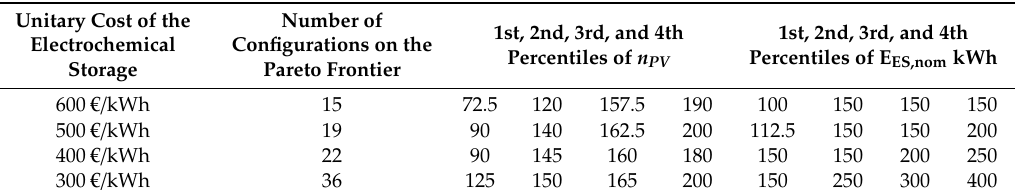
Table 6. Percentiles of the number of PV collectors and nominal ES capacity as a function of the unitary cost of the electrochemical storage.